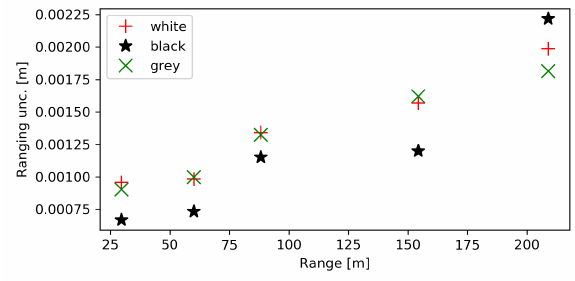
Figure 4. VZ-2000i ranging uncertainty vs. range for a constant incidence angle of 0 ◦ .